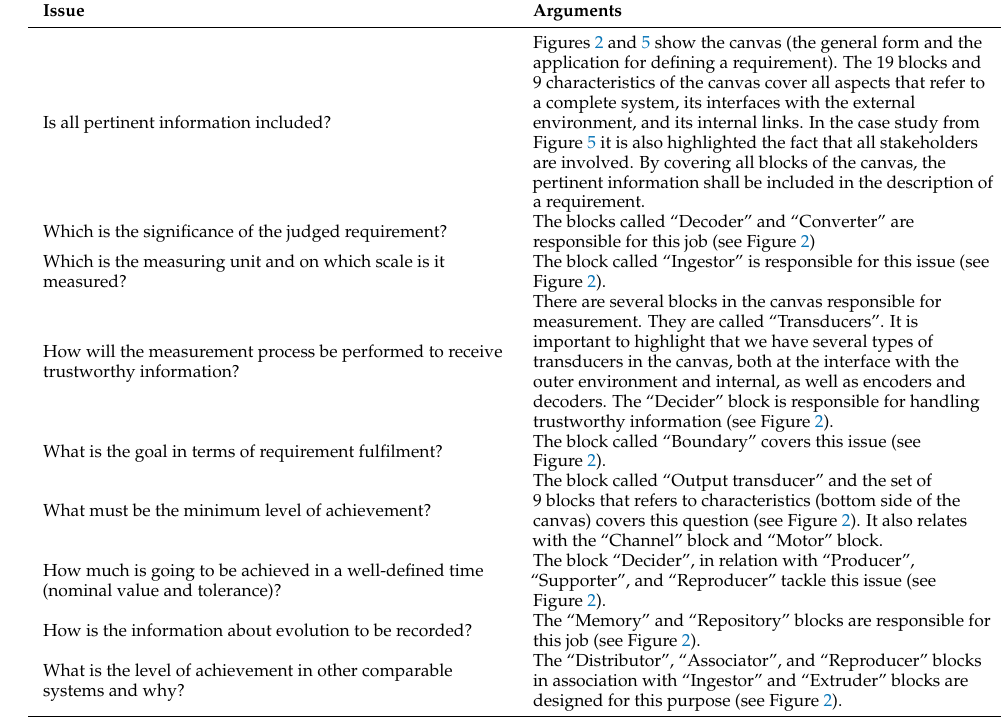
Table 5. Analysis of the proposed